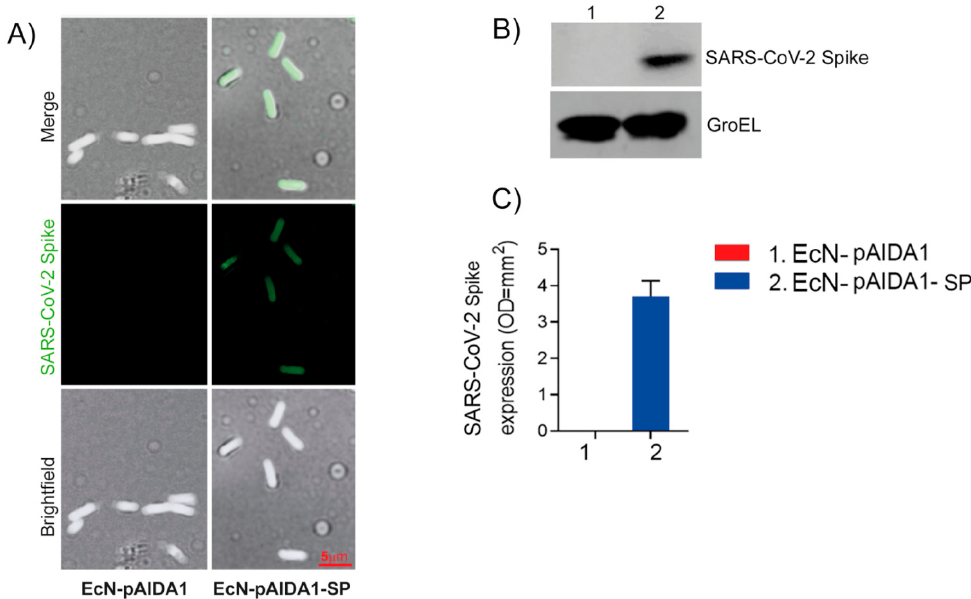
Figure 1. EcN-pAIDA1-SP expresses SARS-CoV-1 spike protein on the cell surface as shown by immunofluorescence and brightfield (100 × magnification) ( A ) and Western blot analysis for SARS- CoV-2 spike protein S1 quantification ( B , C ), (see Supplementary Figure S3 for uncropped blot). Results are expressed as mean ± SD of n = 4 experiments performed in triplicate.